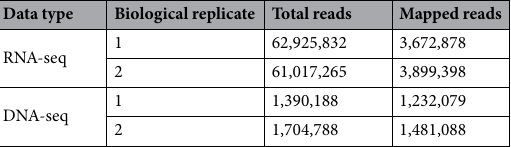
Table 1. Summary of sequencing reads generated for each sample. A large proportion of reads generated in the RNA-seq libraries originate from ribosomal RNA, which were not included in the mapping